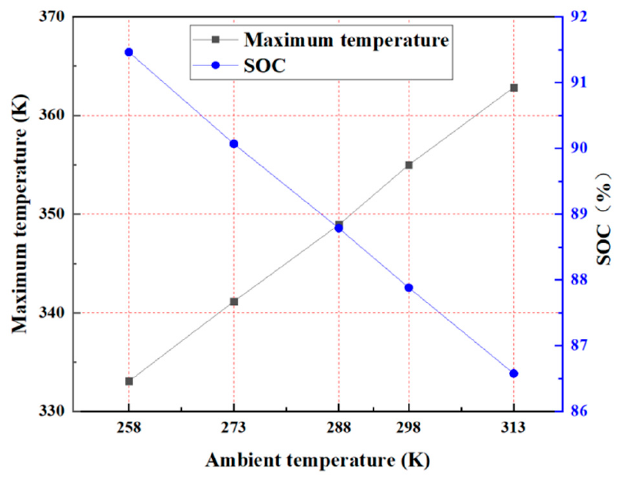
Figure 12. Relationships for the maximum hydrogen temperature and SOC with the ambient temperature at the end of filling.